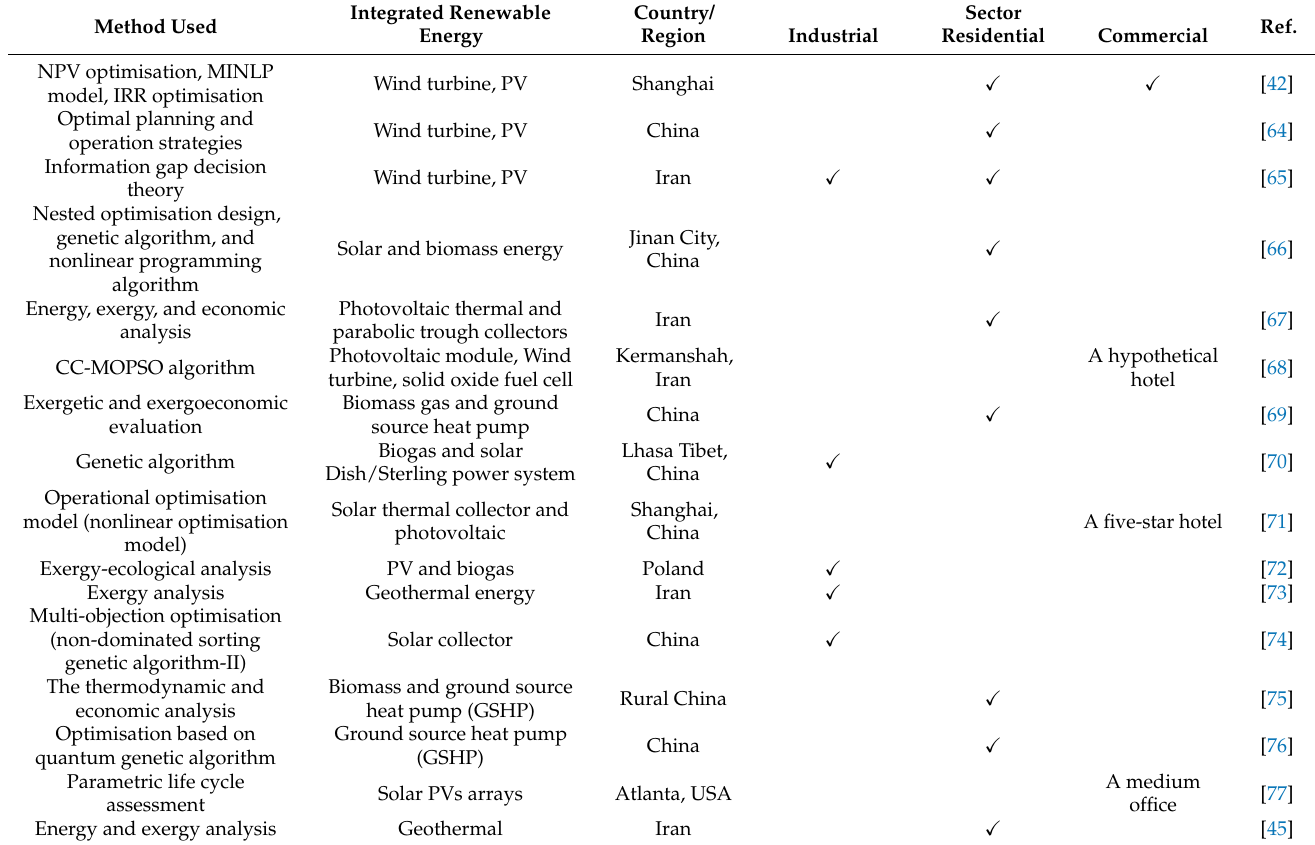
Table 3. Methods, geographical locations, renewable energy types, and sector details of studies related to CCHP